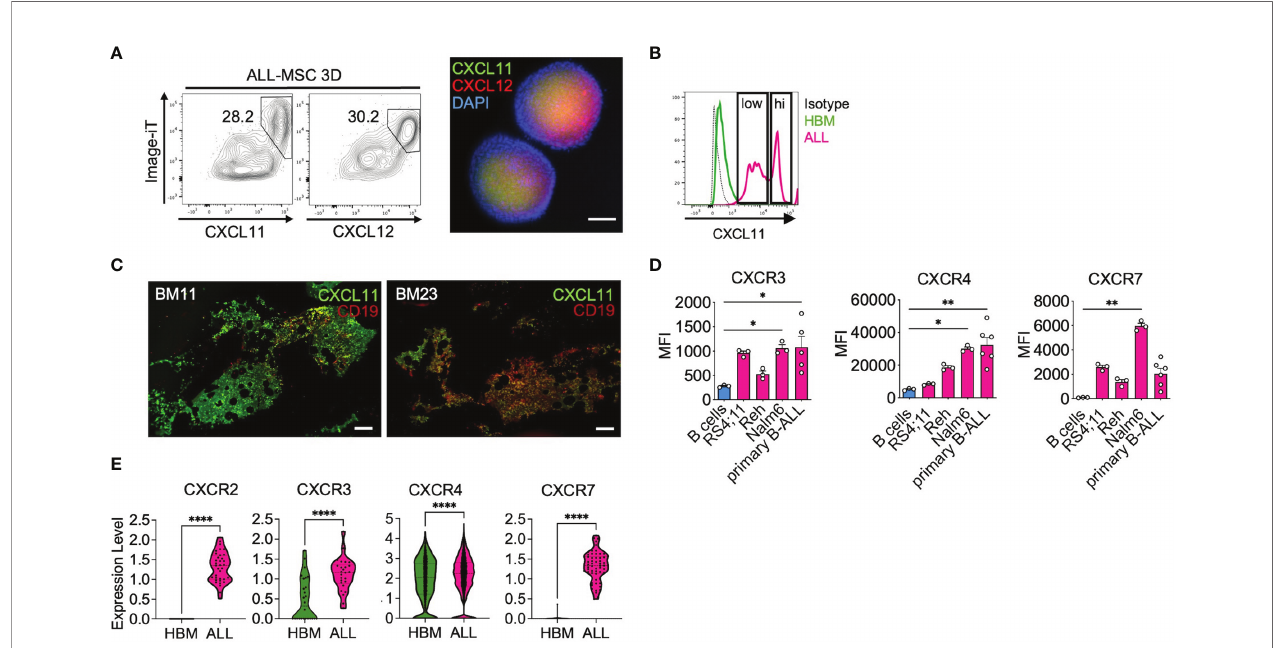
FIGURE 7 | CXCL11 characterize the MSC niche in B-ALL. (A) CXCL11 and CXCL12 was hypoxia-tracked by using the image-iT probe and analyzed by FACS and representative CXCL11 and CXCL12 immuno fl uorescence staining in ALL-MSC spheroids ( n = 3). (B) CXCL11 was determined by FACS in HBM-MSC and ALL- MSC spheroids (nHBM-MSC = 3, nALL-MSC = 9). (C) CXCL11 and CD19 immunostaining in BM biopsies. (D) CXCR3, CXCR4, and CXCR7 expression analyzed by FACS in B-ALL cell lines ( n = 3) and primary B-ALL cells ( n = 6). (E) Expression of CXCR2, CXCR3, CXCR4, and CXCR7 in B-ALL and Healthy BM CD19+CD79+ populations obtained from database GSE132509 analyses. MSC, mesenchymal stromal cell; HBM, healthy bone marrow; B-ALL, B-cell acute lymphoblastic leukemia; CAR, CXCL12-derived abundant reticular; FACS, Fluorescence-activated cell sorting. *P < 0.05; **P < 0.01; ****P < 0.0001. Error bars represent